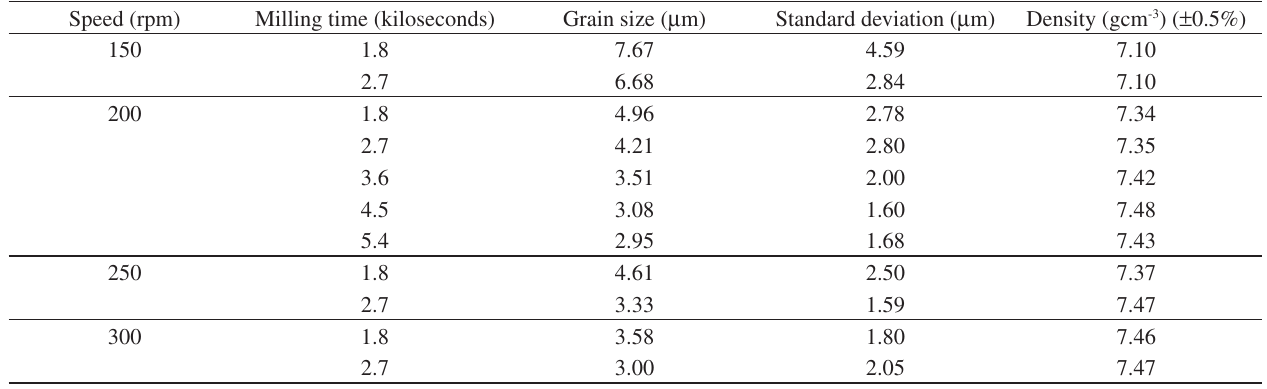
Table 1. Microstructural parameters and densities for the Pr